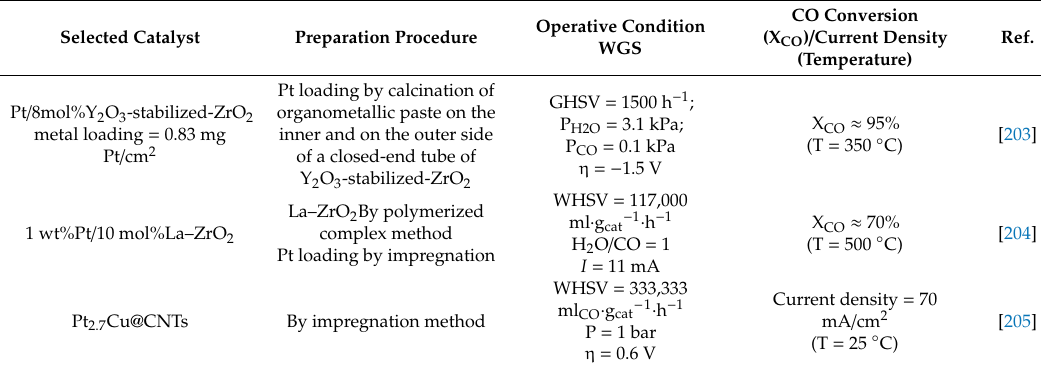
Table 14. Summary of preparation procedures and operative conditions used in electrochemical promotion of catalysis (EPOC) applied to WGS